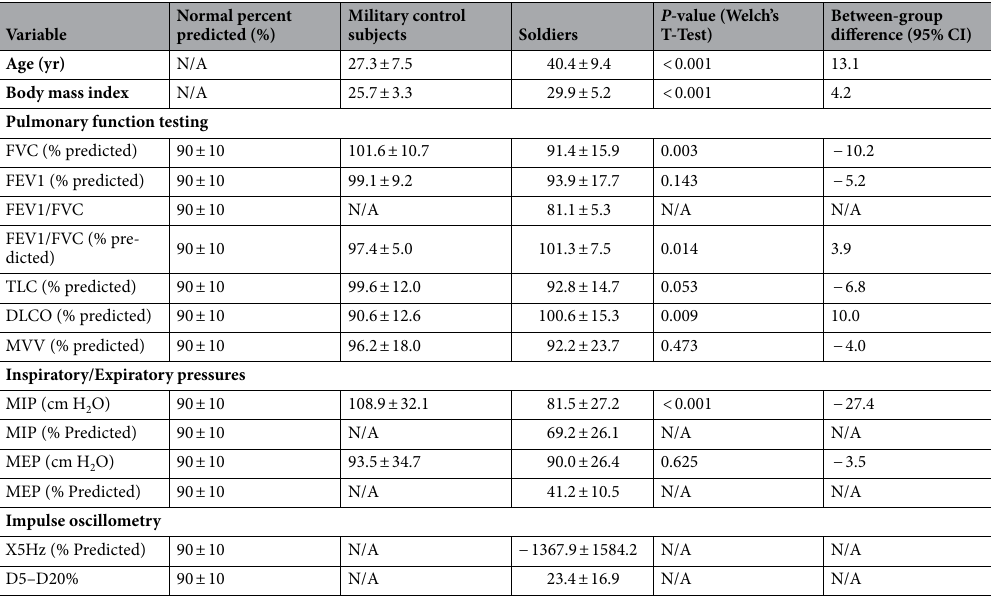
Table 2. Pulmonary function, and impulse oscillometry testing in the 31 soldier cohort. Military control subjects 35